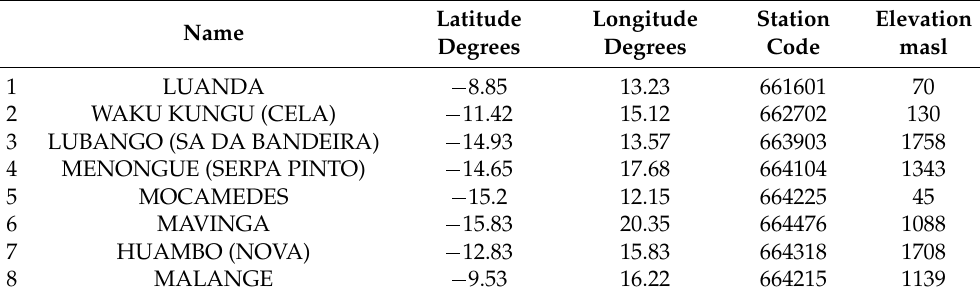
Table 2. List of climate stations with monthly rainfall and temperature data.